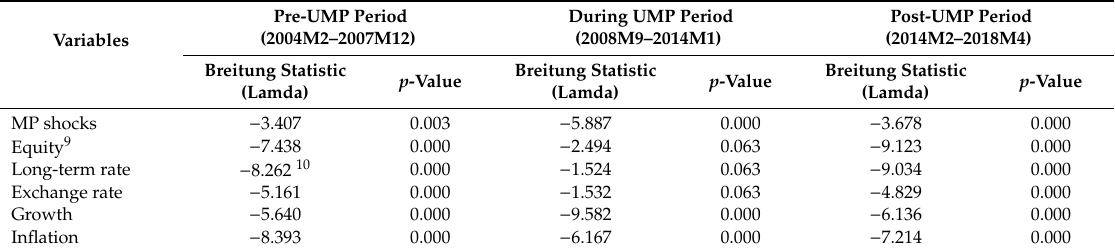
Table A3. Unit root tests for panel